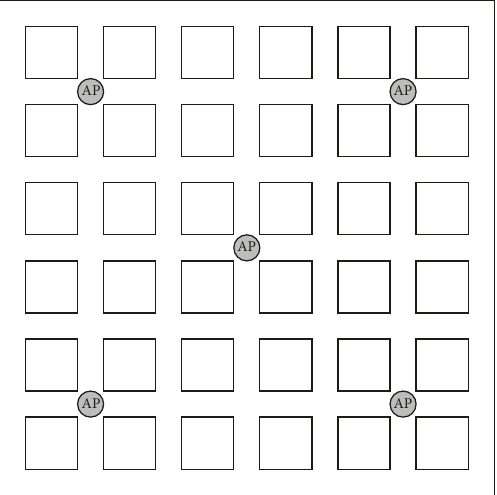
Figure 11: Distribution of the 5 APs within our simulation scenario.